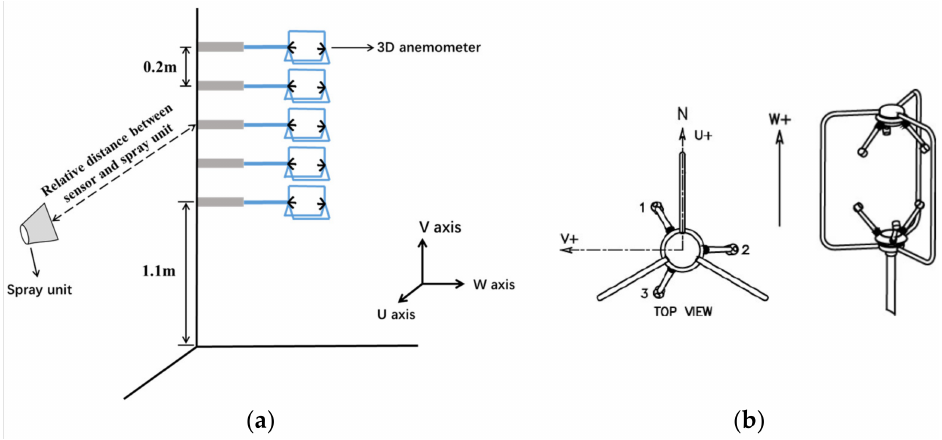
Figure 3. Diagram of the wind field test: ( a ) location of the air-assisted spray unit and 3D anemome- ters; ( b ) 3D coordinates of the